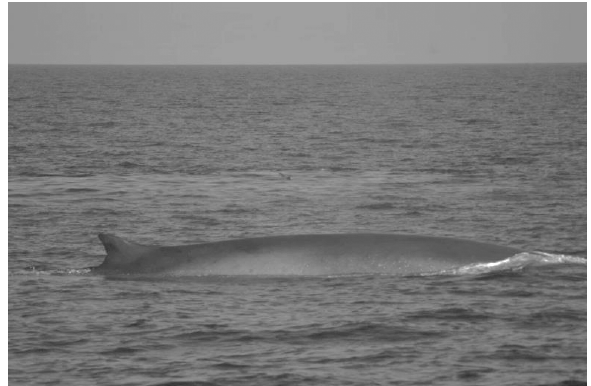
Figure 2. Fin whale during survey in Ionian Sea. (Photo by Ketos association).